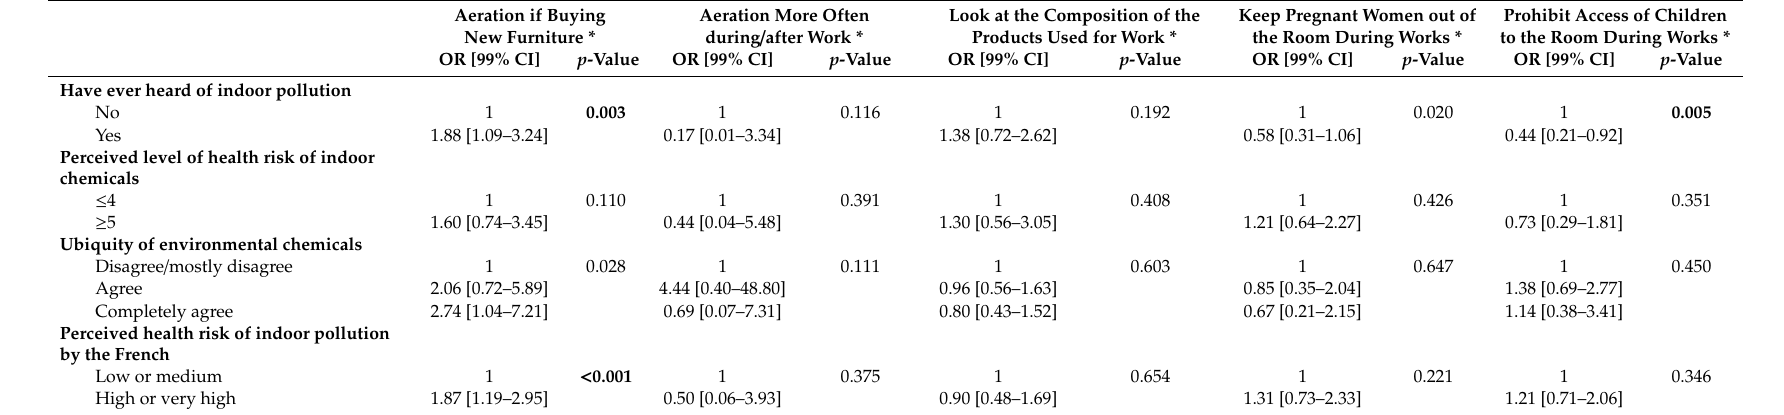
Table 6. Practices concerning furniture and works according to the level of awareness /